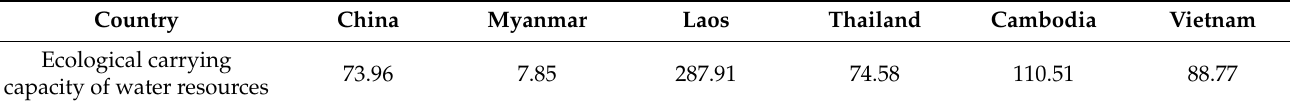
Table 6. Ecological carrying capacity of water resources in LMRB unit: 10 6 hm